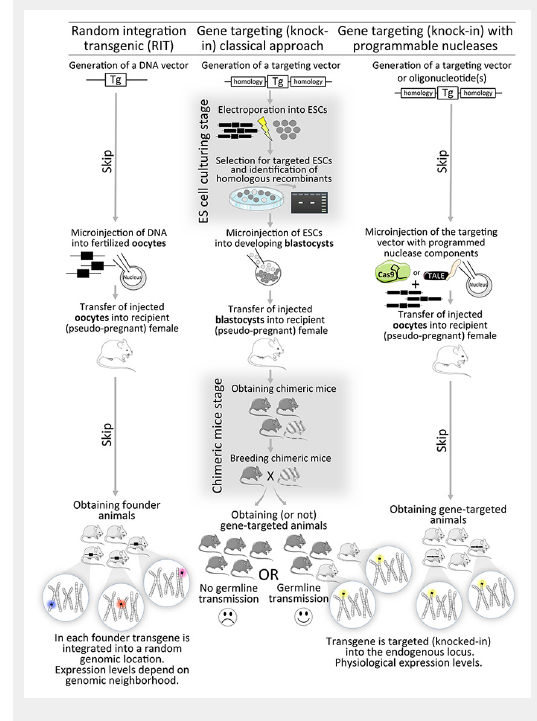
A comparison of strategies to genetically engineer mice. The random integration approach (left workflow) is useful for adding new genes, and is technically straightforward, but suffers from position effects (transgenes on different chromosomes on the bottom). The gene targeting approach (middle workflow) is more laborious, requiring embryonic stem cell (ESC) culturing, and breeding of chimeras, which often fail to transmit the transgene to their progeny. The breakthrough of the gene targeting approach employing guided nucleases (right workflow), is that the final result of gene-targeted mice is obtained without the ESC culturing and chimera breeding